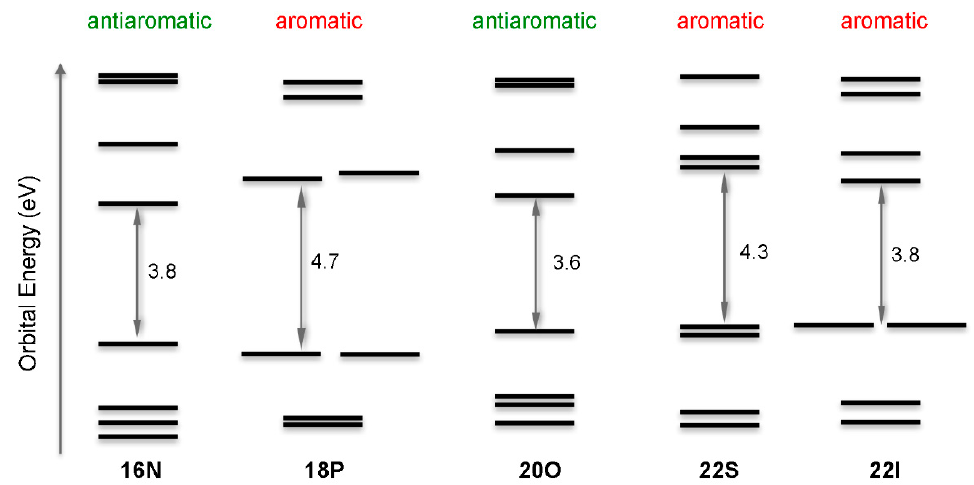
Figure 7. Schematic diagrams for the energy levels of selected molecular orbitals of aromatic and antiaromatic porphyrinoids. The HOMO-LUMO gap (in eV) is also shown